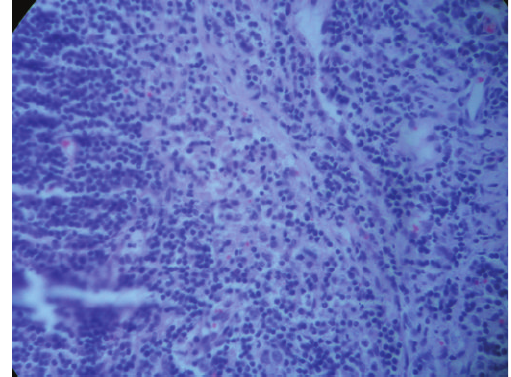
Figure 2: Gram stain from blood culture bottle shows gram- positive cocci in